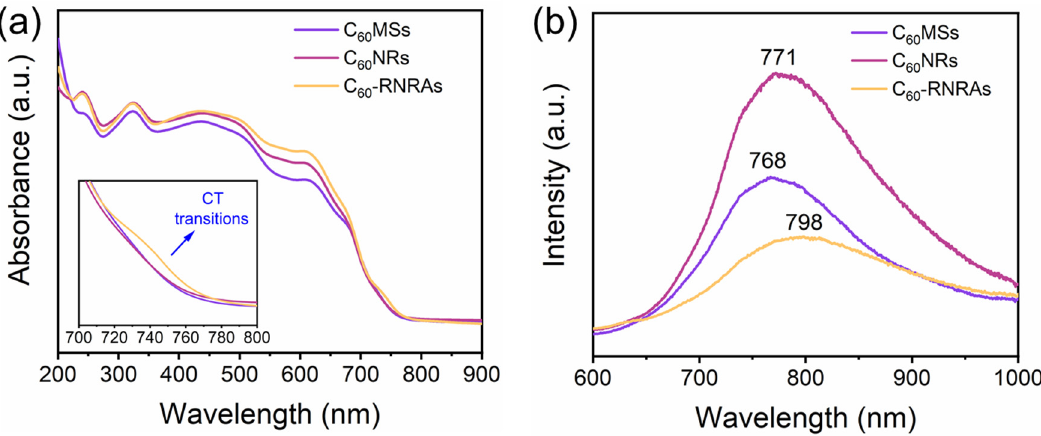
Figure 5. ( a ) UV-vis absorption spectra and ( b ) PL spectra of C 60 MSs , C 60 NRs , and C 60 -RNRAs.